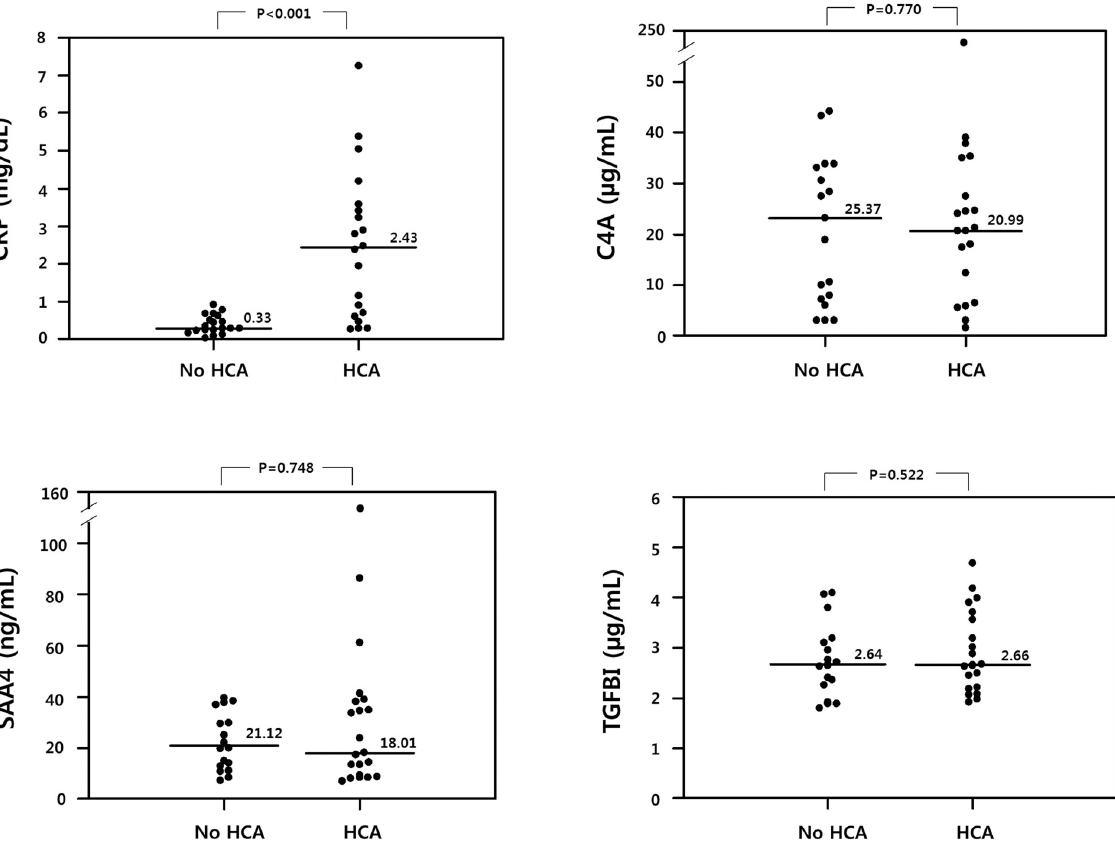
Fig 4. Plasma levels of C-reactive protein (CRP), complement C4-A (C4A), serum amyloid A4 (SAA4), and transforming growth factor- beta-induced (TGFBI) in histologic chorioamnionitis (HCA) cases and non-HCA controls. All samples analysed (n = 20 and 18, respectively) were from study cohort 2. Horizontal lines indicate the respective median